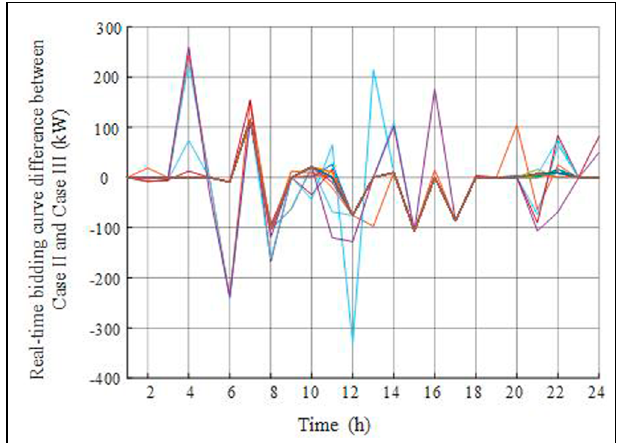
FIGURE 3 | Prices in the day-ahead and forecast prices in the real-time electricity markets.